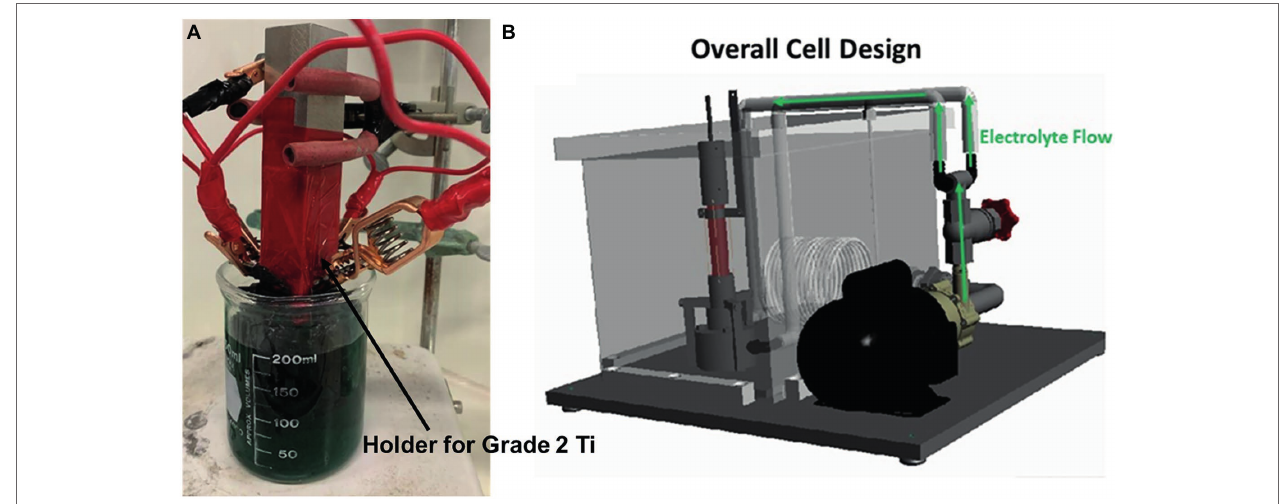
FIGURE 1 | Setup for a rectangular Ti sample used for preliminary coating screening (A) , and tool for applying a coating to Ti surface (B)